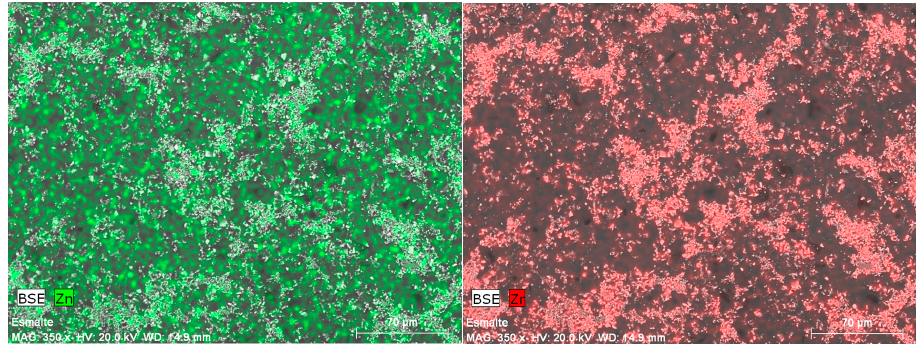
Figure 12. SEM applying 350 magnifications of the second glaze ZrO 2 layer. Distribution of Zn and Zr.